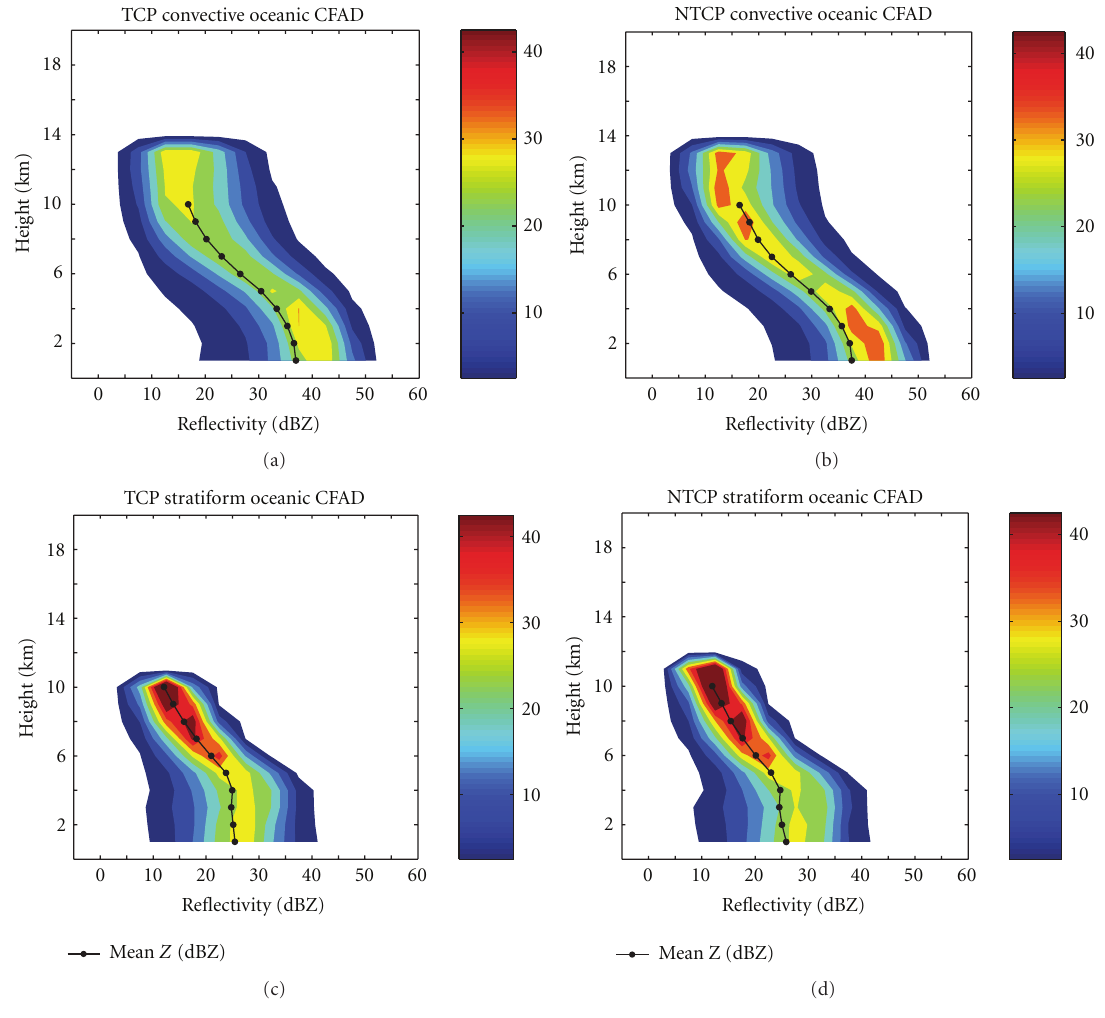
Figure 15: Same as Figure 14 except for oceanic